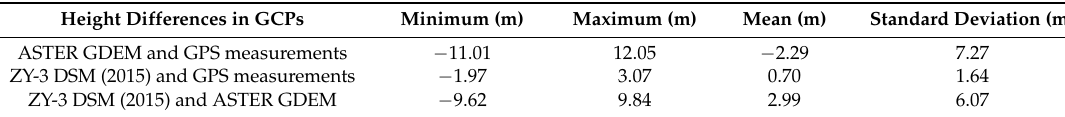
Figure 10. Comparison of height values extracted from ASTER GDEM and ZY-3 DSM (2015) with twelve ground control points. Table 8. Comparison of height values in twelve ground control points.